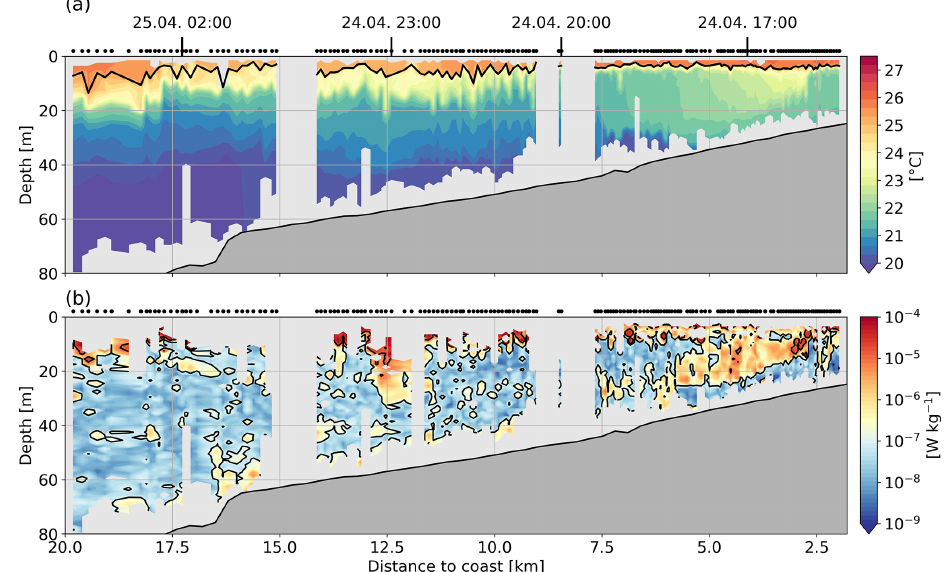
Figure 11. Shipboard section taken at 11 ◦ S in April 2022. Panel (a) shows temperature (colours) and MLD (black line). Panel (b) displays the dissipation rate of TKE below the ML. Black points at the top of both panels mark the position of individual microstructure